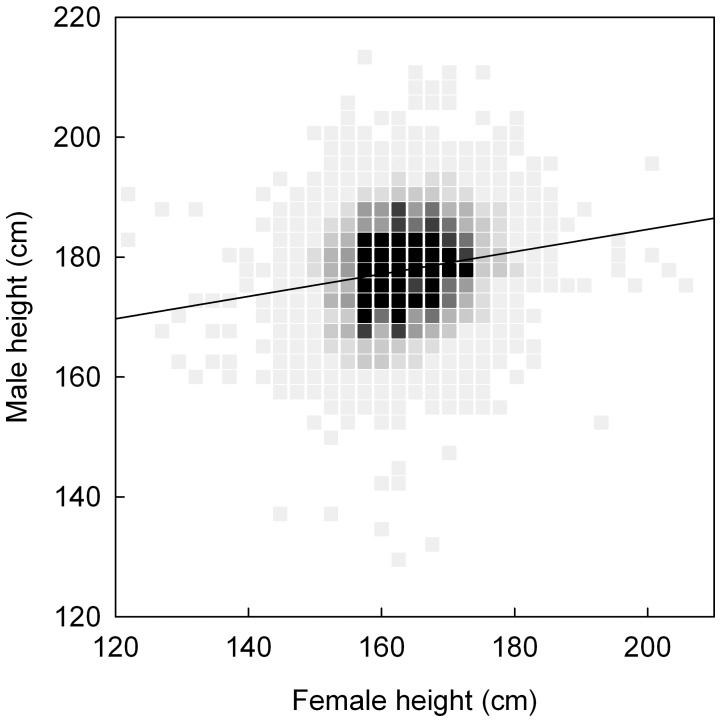
The positive correlation between female and male height (r = .18).Lumination indicates frequency of occurrence (lightest color <20 couples; darkest color >200 couples).